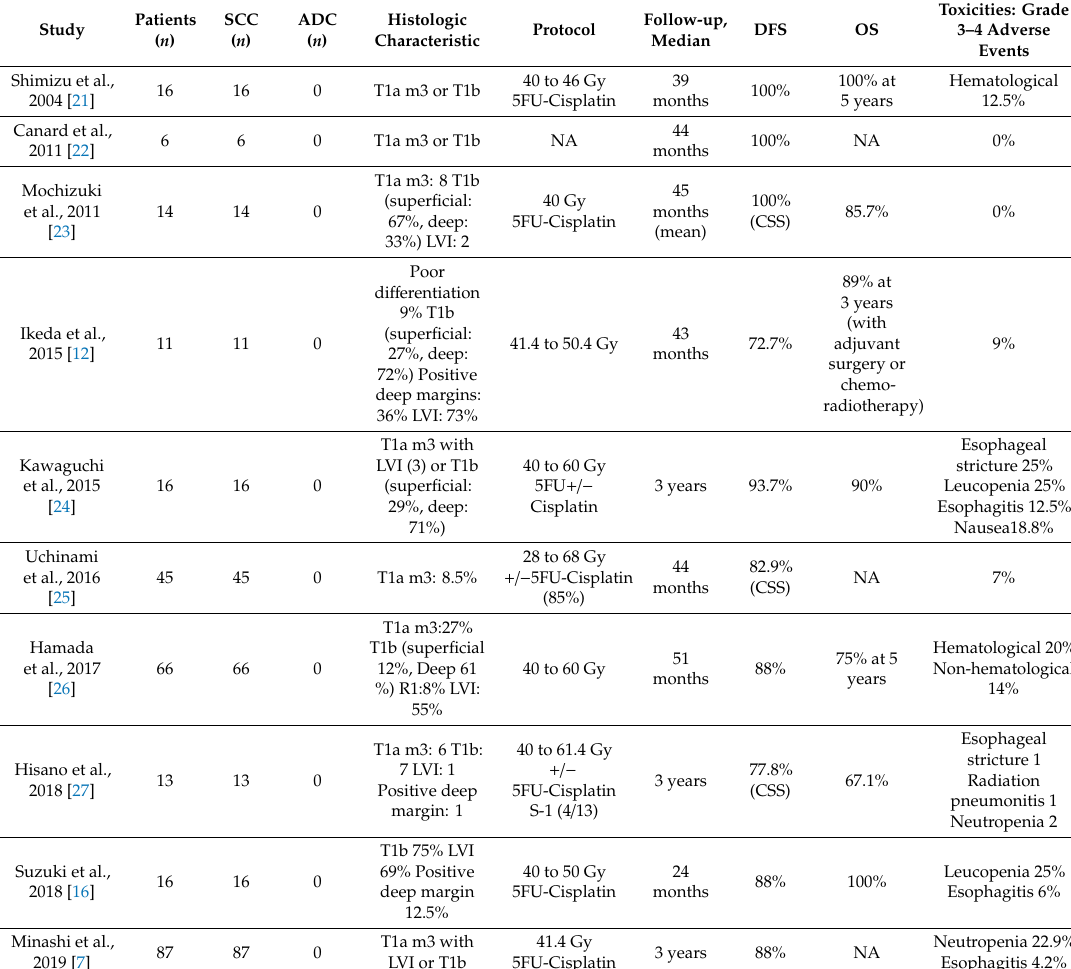
Table 3. Studies reporting on outcomes of chemoradiotherapy after non-curative endoscopic resection of early esophageal